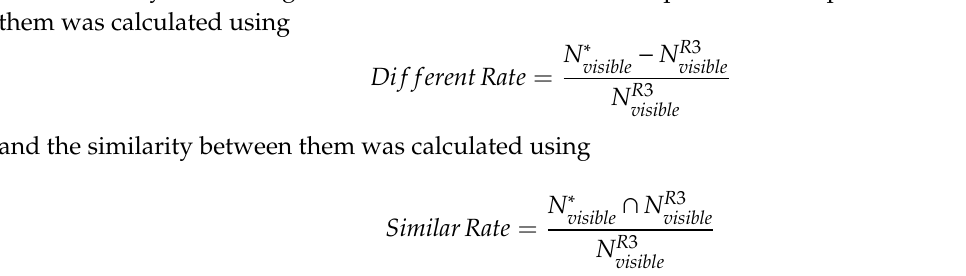
Figure 20. Schematic diagram of the intersection and difference sets. ( a ) The difference set (B-A); and ( b ) the intersection set (A ∩ B).